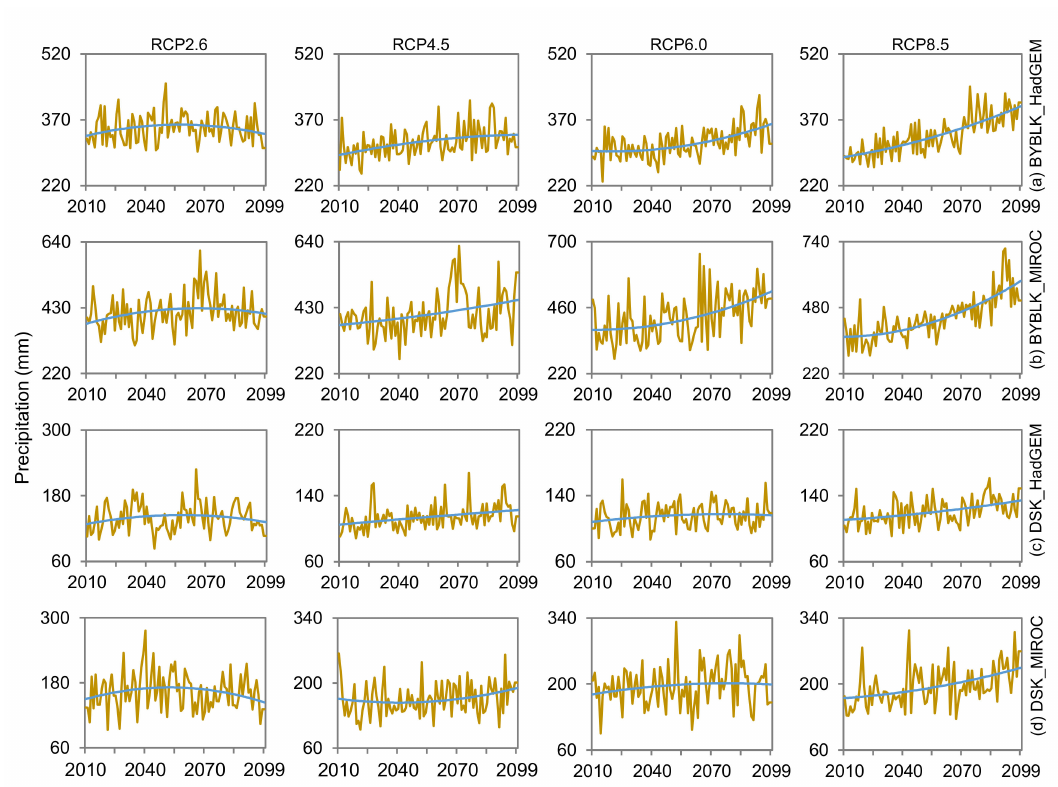
Figure 4. Projected annual precipitations during the period 2010–2099 [( a , b ) are under the models of HadGEM and MIROC in Bayanbulak station; ( c , d ) are under the models of HadGEM and MIROC in Dashankou